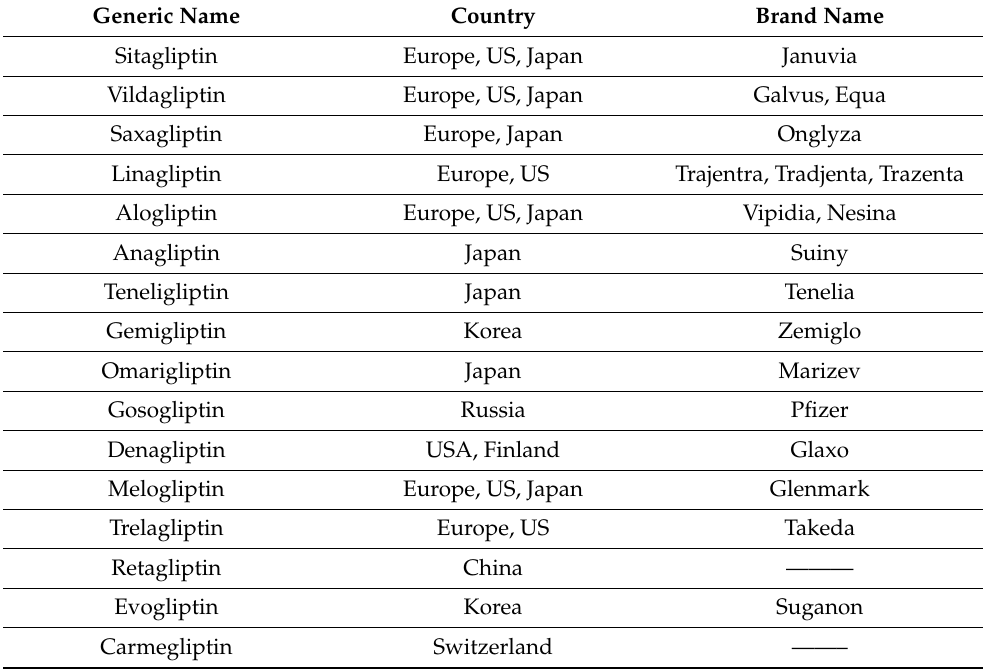
Figure 2. Diagrammatic representation of the mechanism of DPP-IV and potential role of protecting incretin hormone degradation by DPP-IV enzyme to maintain the homeostatic blood glucose level. Abbreviations: gastrointestinal tract (GI), dipeptidyl peptidase-IV inhibitor (DPP-IV), glucagon-like peptide-1 (GLP-1). Table 1. Currently used DPP-IV inhibitors approved by the respective country or which are undergo- ing clinical